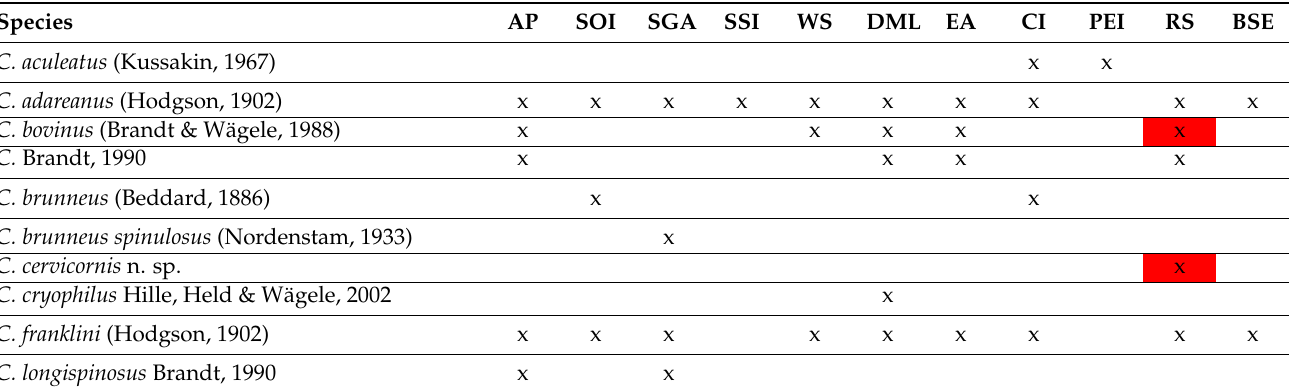
Table 1. Chaetarcturus Brandt, 1990 species presence-absence table: “x” indicates presence in the area, red “x” indicates MNA new record in the area. Areas in this study are AP (Antarctic Peninsula), SOI (South Orkney Islands), SGA (South Georgia Area), SSI (South Sandwich Islands), WS (Weddell Sea), DML (Dronning Maud Land), EA (East Antarctica), CI (Crozet Islands), PEI (Prince Edward Is- lands), RS (Ross Sea), BSE (Bellingshausen Sea East). “ND” in “ Chaetarcturus Brandt, 1990” indicates undetermined Chaetarcturus